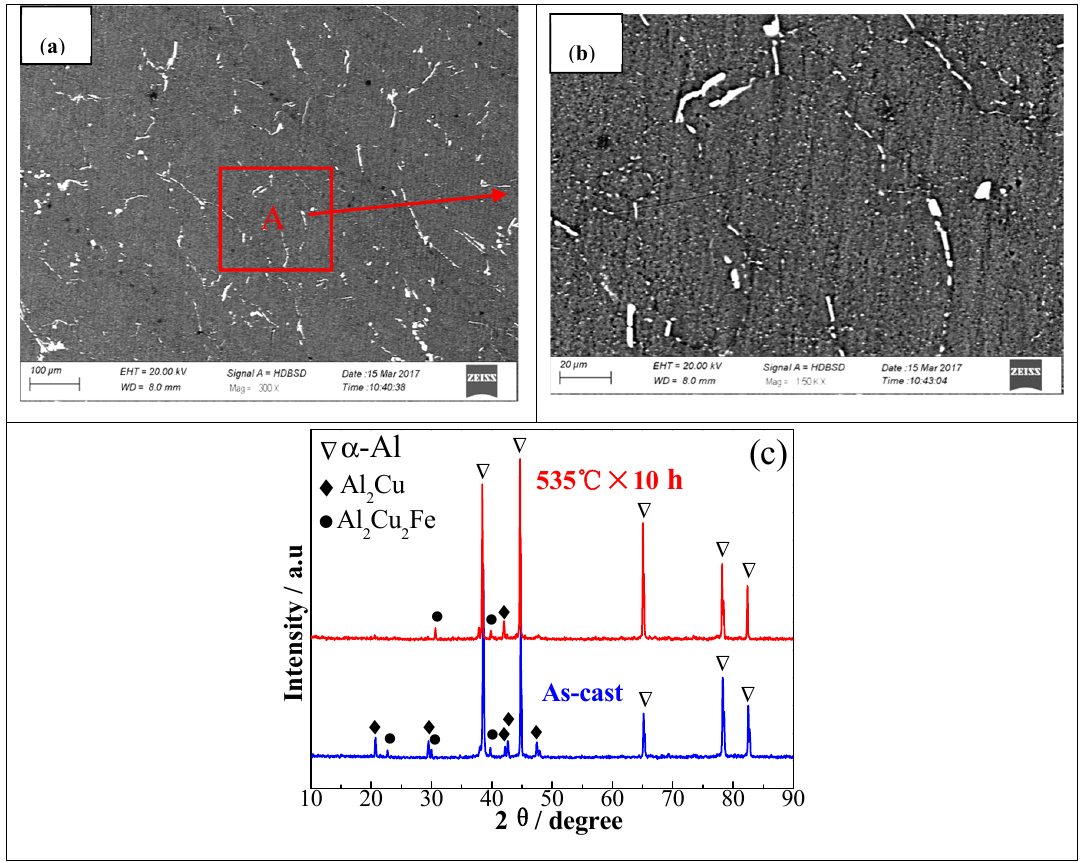
Figure 8. Microstructures and XRD spectra of 2219 aluminum alloy homogenized at 535 °C: ( a ) 535 °C × 10 h; ( b ) the corresponding local magnified map from Figure 5a; ( c ) X-ray diffraction patterns of the as-cast and homogenized alloy.